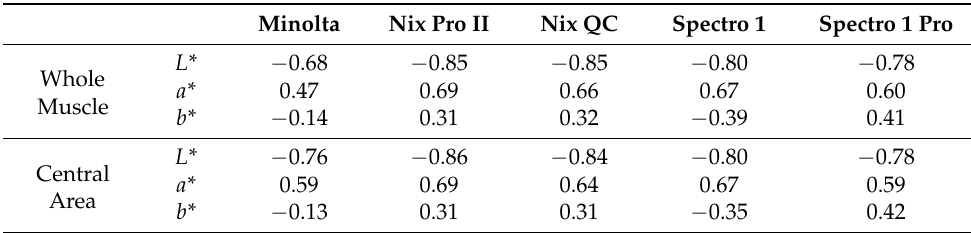
Table 5. Correlation coefficients of instrumental measurement with Canadian pork colour standard on fresh pork colour. Minolta Nix Pro II Nix QC Spectro 1 Spectro 1 Pro L* − 0.68 − 0.85 Whole Muscle